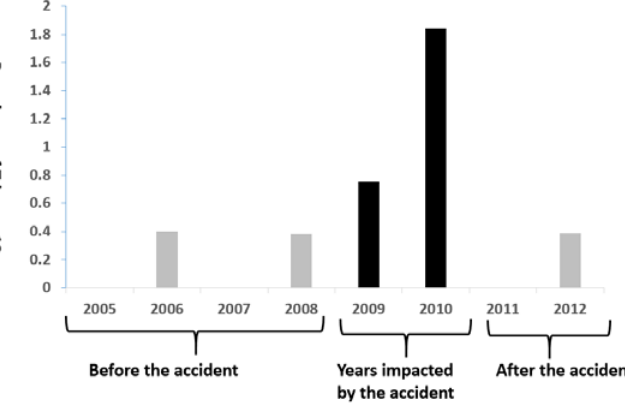
Figure 1. Annual prevalence of T18 between 2005–2012 in Brazos County, Texas.